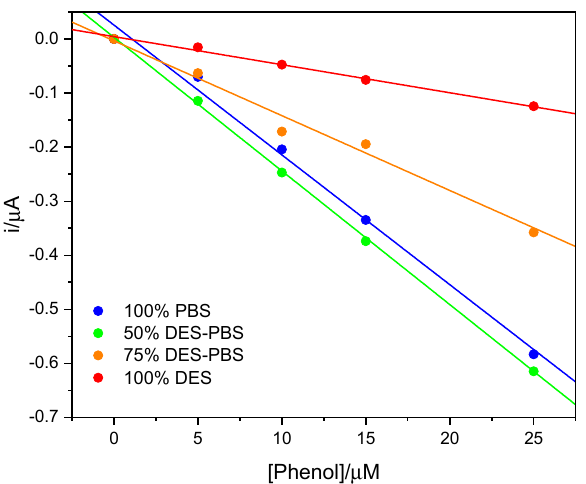
Figure 4. The calibration lines of the phenol in 100% PBS (blue line), 50% v / v DES-PBS (green line), 75% v / v DES-PBS (orange line), and 100% DES (red line).